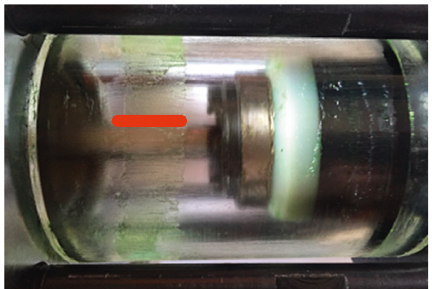
Figure 15: Surface lubrication of pistons. The length of the red line is the oil film width.